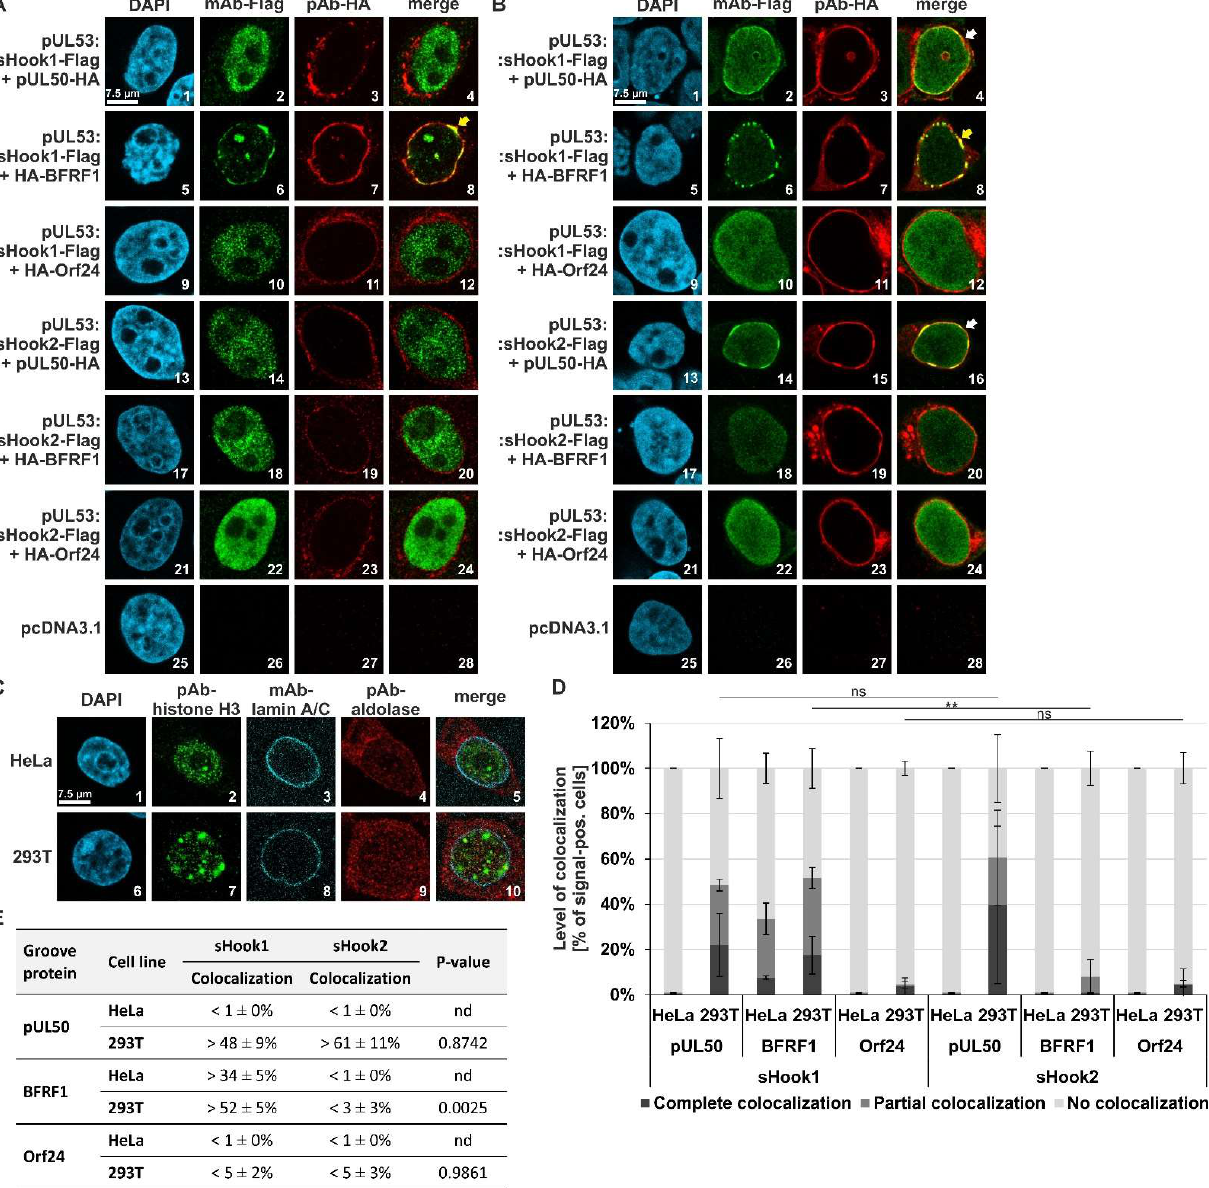
Figure 11. Qualitative and quantitative analyses of nuclear rim colocalization patterns: coexpressed sequence-predicted hybrid constructs (HCMV/EBV pUL53 sHook1 and HCMV/VZV pUL53 sHook2) in combination with three different groove proteins (HCMV pUL50, EBV BFRF1 or VZV Orf24). ( A ) HeLa or ( B ) 293T cells were transiently cotransfected with either constructs coding for the Flag- tagged sequence-predicted hooks, sHook1 or sHook2, and the HA-tagged groove proteins pUL50, BFRF1 or Orf24. Two d p.t., cells were fixed, used for immunostaining with tag-specific antibodies and analyzed by confocal imaging. DAPI counterstaining indicated the morphology of nuclei of the respective cells. In both types of cells, the localization patterns of coexpressed construct pairs were analyzed; the scale bar in panels A–C, picture 1 marks 7.5 µ m. On a qualitative level of analysis ( A , B ), the yellow arrows indicate complete nuclear rim colocalization, and the white arrows show partial rim colocalization. ( C ) Staining of subcellular localizations of marker proteins in HeLa and 293T cells, i.e., the nuclear lamina, the nucleoplasmic and cytosolic compartments. ( D ) Quantitation of the colocalization patterns of pUL53 sHook1 and sHook2 with groove proteins HCMV pUL50, EBV BFRF1 and VZV Orf24. Localization patterns observed in HeLa and 293T cells were